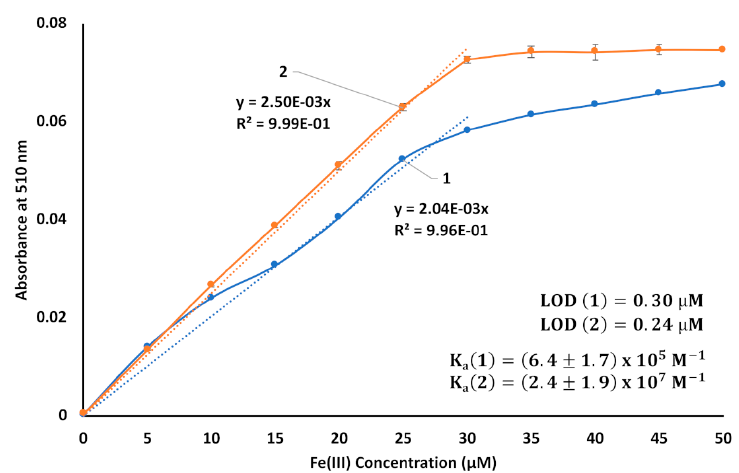
Figure 3. Titration of 1 and 2 with Fe 3+ in 0.1 M acetate buffer at pH 3. The chelator concentration was held constant at 30 µ M. The inset gives the association constants ( K a ) corresponding to the formation of the 1:1 complexes, along with the limits of detection (LODs) determined using the following equation: LOD (x) = 3 × SD b × m x − 1 where SD b = standard deviation of the blank and m x = the slope of the titration